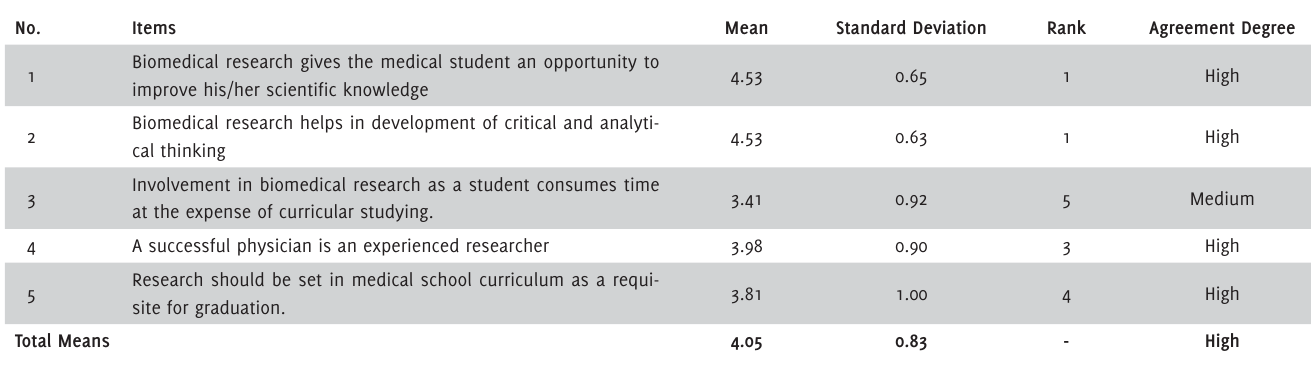
Table 2. Responding Student Perceptions of Research at